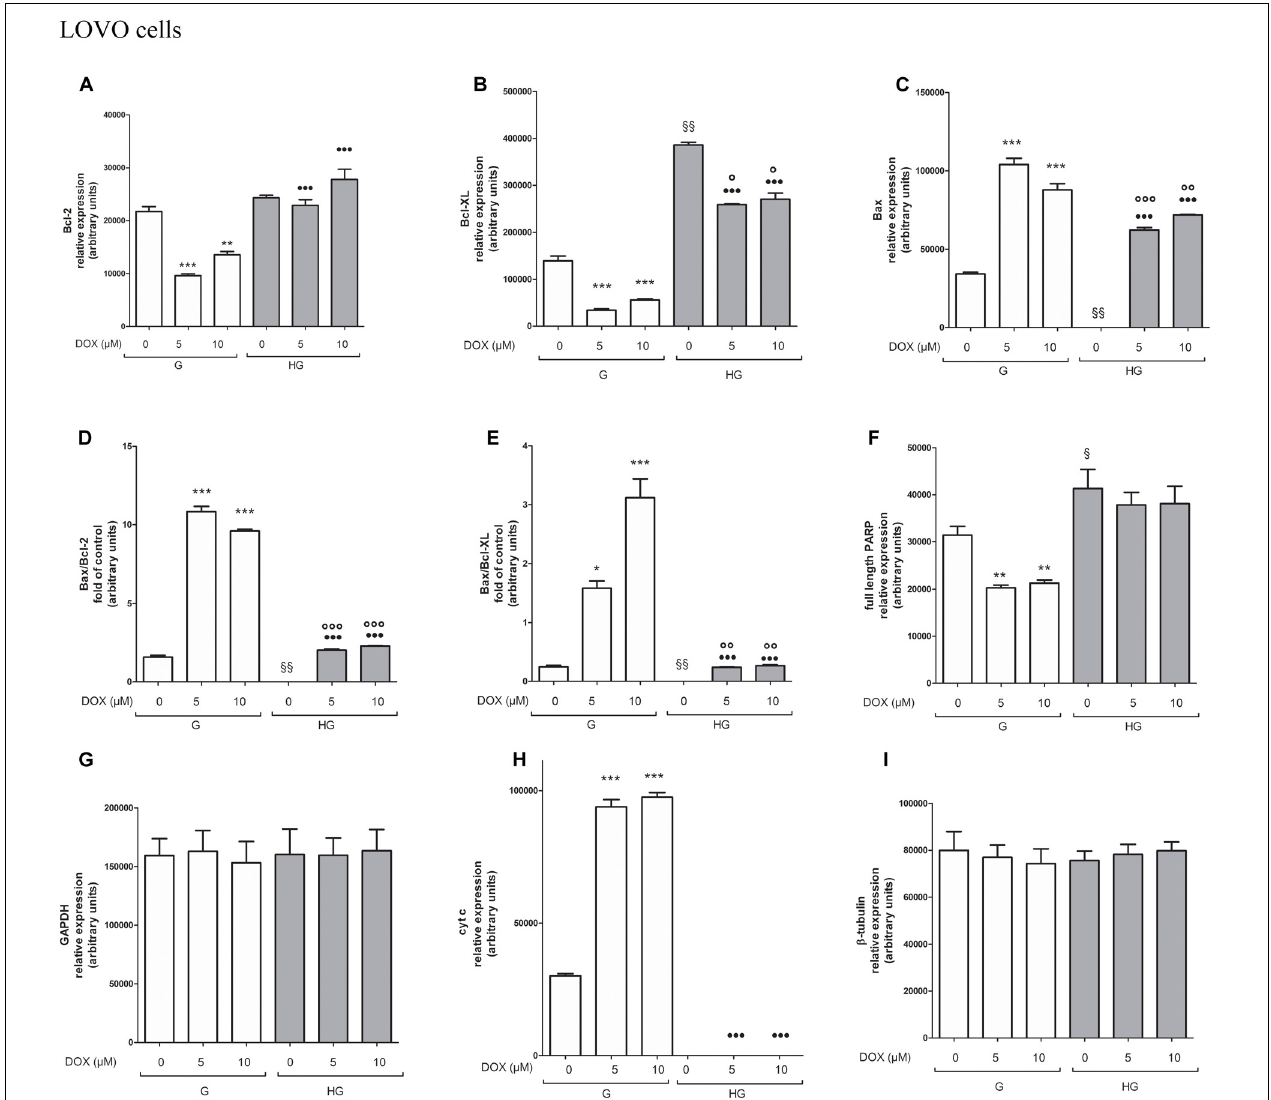
FIGURE 11 | Densitometry of Bcl-2, Bcl-XL, Bax, PARP and cyt c protein expression in absence or presence of DOX in human colon cancer LOVO cells in G and HG conditions. The protein bands of three independent experiments have been quantified by densitometry and the values are expressed as arbitrary units. (A)